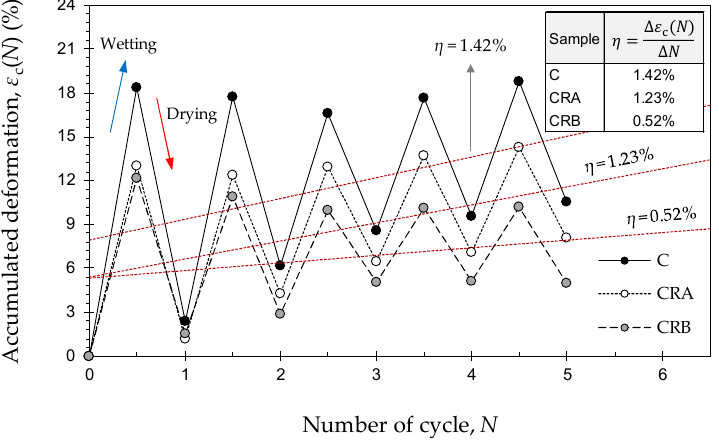
Figure 8. Swell–shrink patterns for the tested samples.